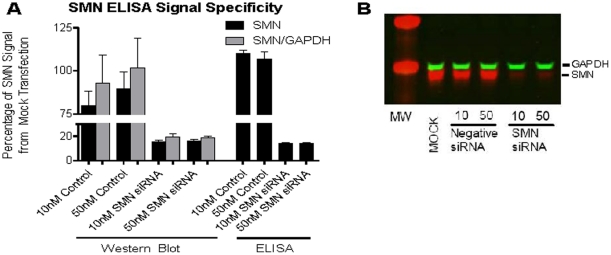
Specificity of SMN ELISA signal detection.To confirm that ELISA signals are specific to SMN protein, SMA Type I fibroblasts were treated with siRNA to knock down the expression of SMN protein. Treated cells were lysed and read in the ELISA and an SMN Western blot. A: GM03813 SMN protein levels are reduced by 80–86% compared to mock transfected cells in both Western blot and ELISA analysis. B: The image of the SMN Western blot visually corroborates the reduction in SMN levels induced by siRNA knockdown.